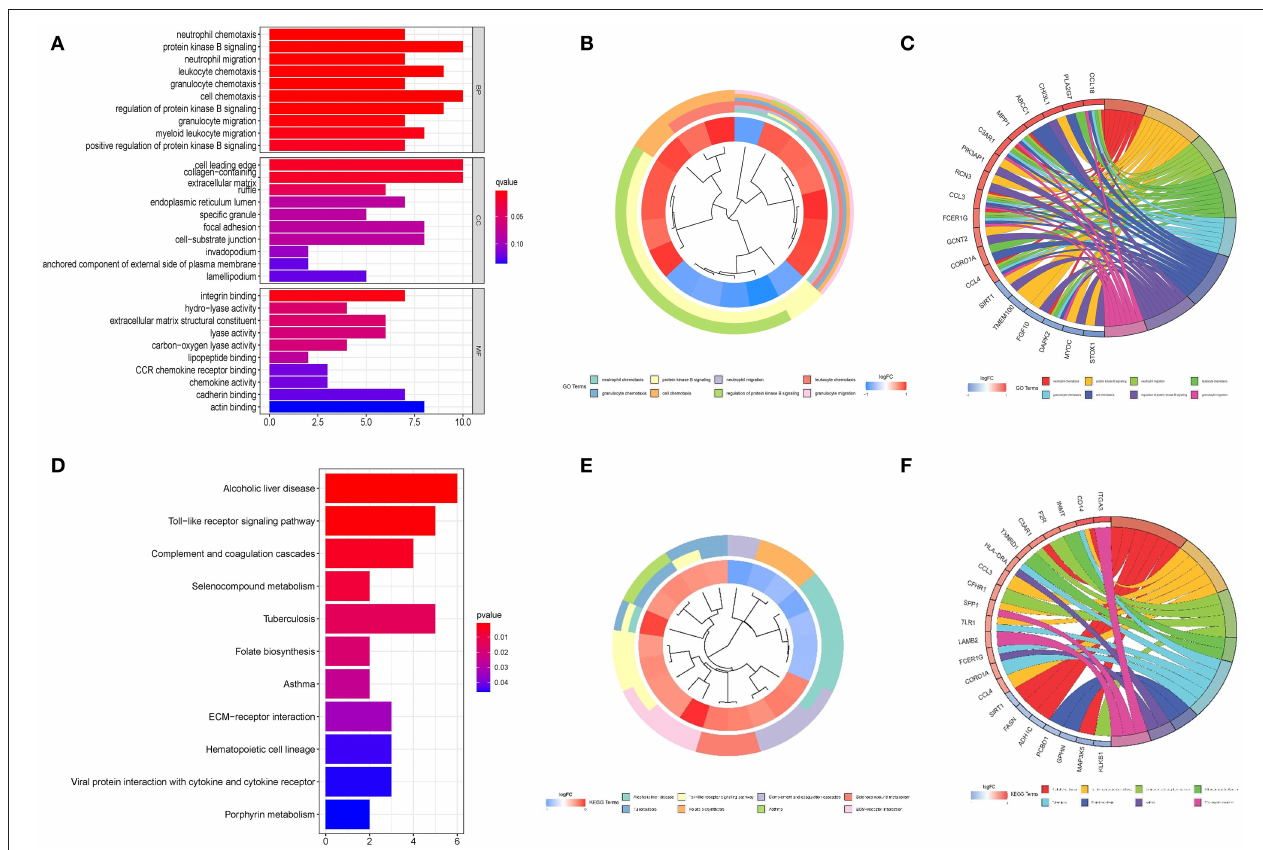
FIGURE 4 | Graph depicting the findings of the enrichment analysis. (A) GO enrichment findings in a bar graph. The z -score is shown on the x -axis, while the log 10 (adj P ) values are represented on the y -axis. (B) Gene clustering circle: the inner circle indicates DEGs, the red circle represents up-regulated genes, the blue circle indicates down-regulated genes, and the outside circle represents GO keywords. (C) GO enrichment ring plot. The DEGs are shown on the left, with the red gene band indicating upregulation and the blue gene band indicating downregulation. The right-hand band, which is colored differently, indicates several GO concepts. The gene’s inclusion in the GO word is shown by the connecting line. (D) KEGG pathway enrichment findings in a bubble chart. The z-score is shown on the x-axis, while the log 10 (adj P ) value is represented on the y-axis. A KEGG pathway is represented by a bubble, the size of which indicates the number of genes in the route. The route enrichment findings in the figure with a log 10 (adj P ) > 1.3 ( P < 0.05) are highlighted and listed in the table. (E) Gene clustering circle: the inner circle indicates DEGs, the red circle represents up-regulated genes, the blue circle indicates down-regulated genes, and the outside circle represents KEGG terms. (F) KEGG pathway enrichment ring plot. The DEGs are shown on the left side, with red gene bands indicating upregulation and blue gene bands indicating downregulation. Distinct colored bands on the right-hand side symbolize different paths. The gene’s involvement in the route is shown by the connecting